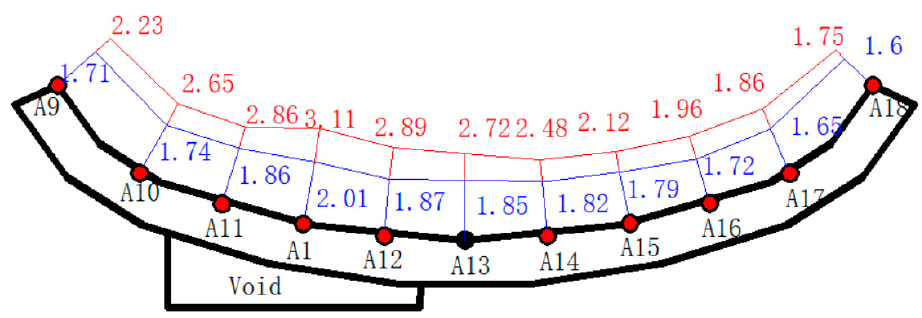
Figure 15. Peak value of the acceleration of each measuring point of the tunnel invert (m/s 2 ). The decay rates of the peak acceleration of the tunnel invert measuring points